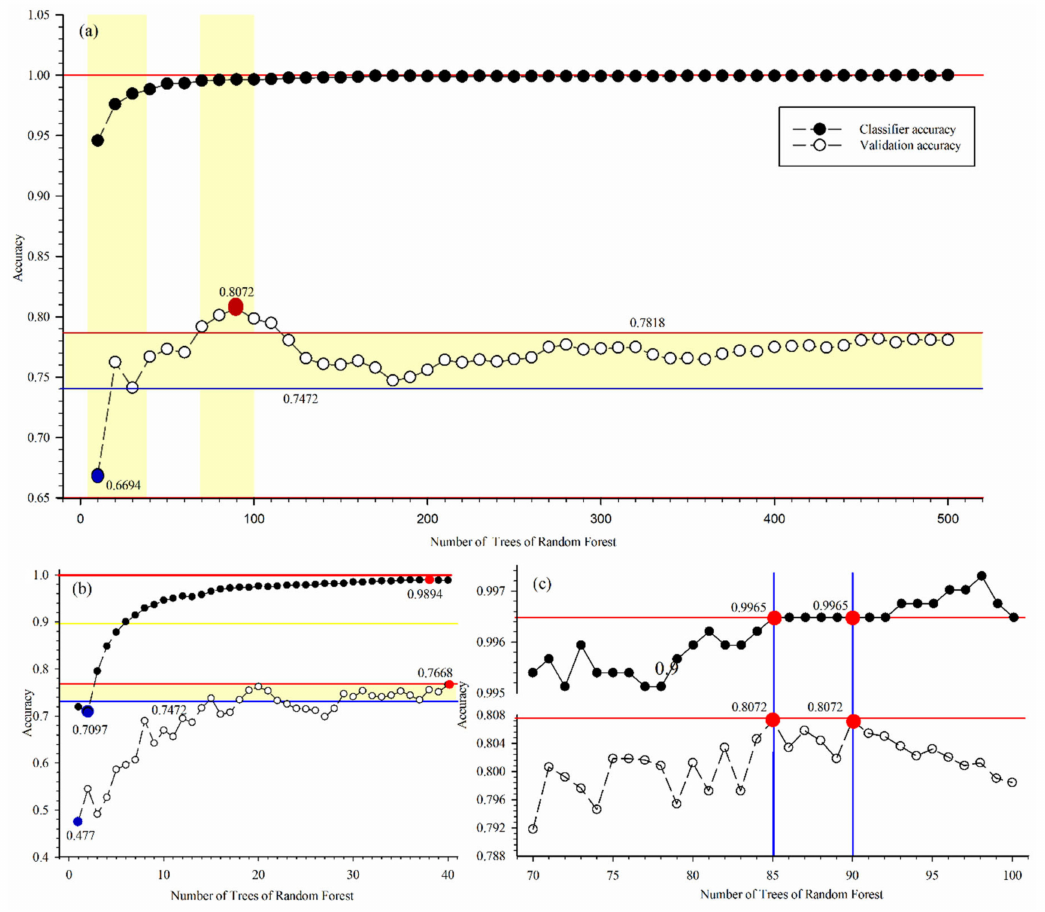
Figure A1. The classifier and validation accuracy with the number of RF trees (( a ). the classifier and validation accuracy with the number of RF trees during 10–500; ( b ). 0–40; and ( c ). 70–100, where the red dot represents the maximum, and the blue dot represents the minimum).